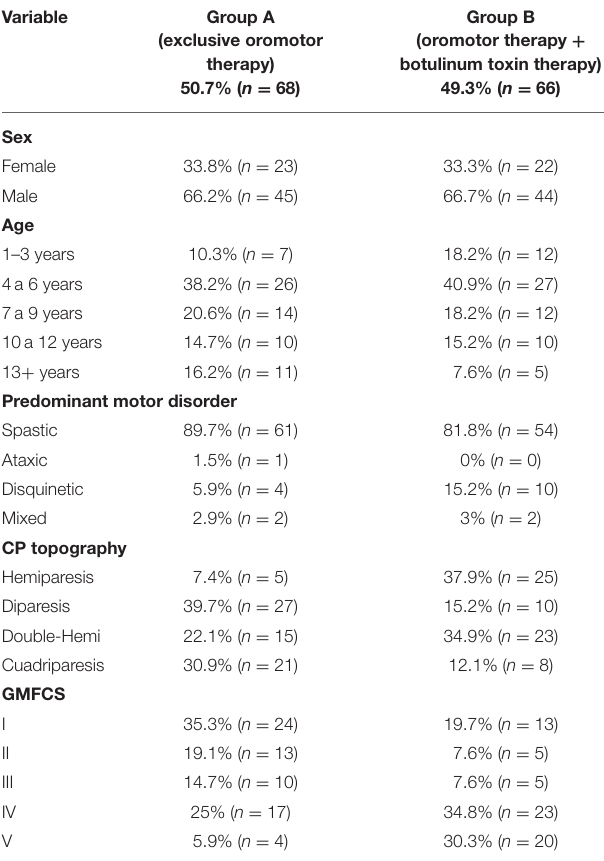
TABLE 1 | Frequencies and means by treatment groups according to age, and characteristics of cerebral